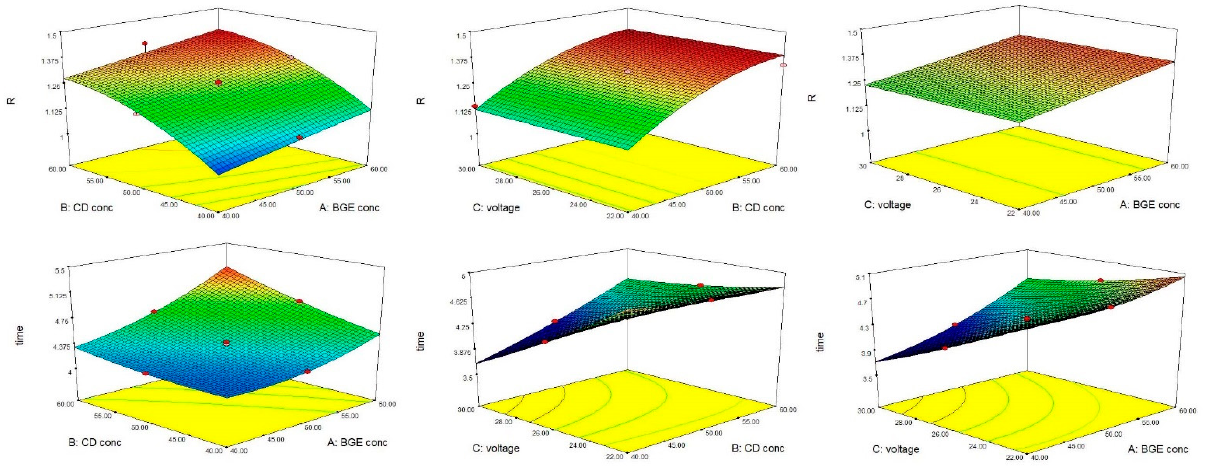
Figure 2. 3D response surface plots for MXL chiral separation (analytical responses: R—chiral resolution, time—migration time).